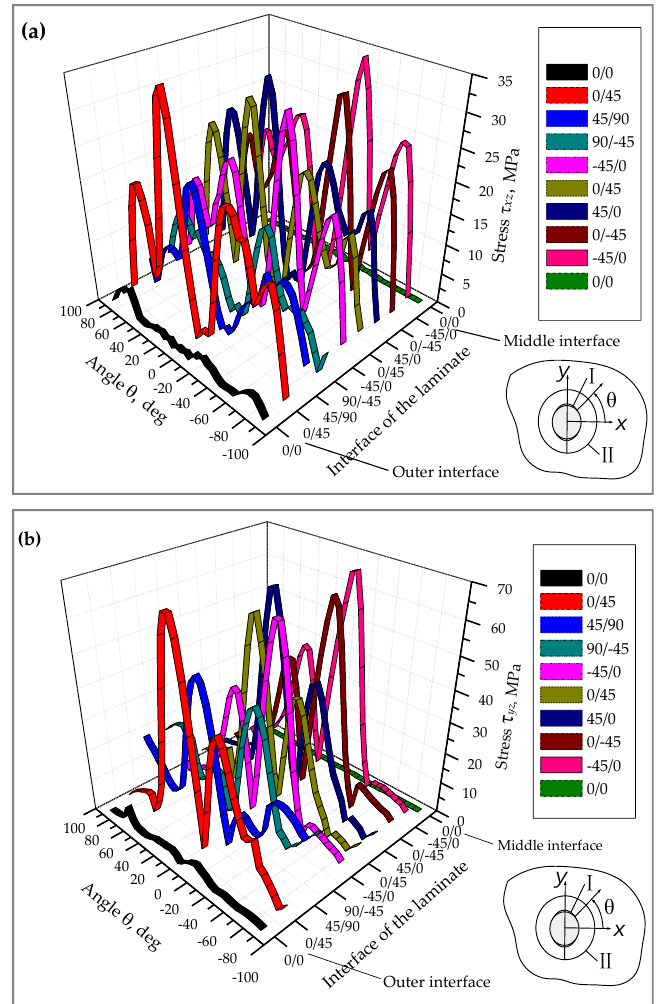
Figure 7. Interlaminar shear stress distributions around Position I: ( a ) τ xz ; ( b ) τ yz . Outer interface—The interfaces located outside the filled-hole laminate, such as the 0/0 and 0/45 interface. Middle interface—The interfaces near the symmetry plane of laminate, such as the −45/0 and 0/0 interface.